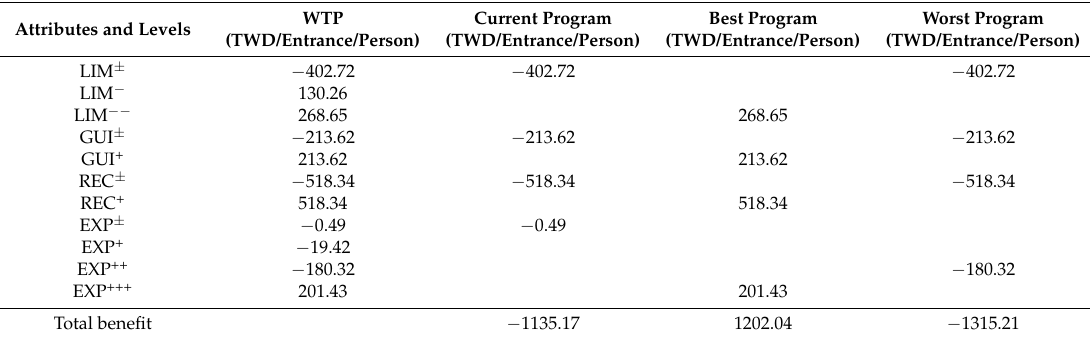
Table 4. Willingness to pay (WTP) for attributes and levels and benefit evaluation of the management program of Orchid Island